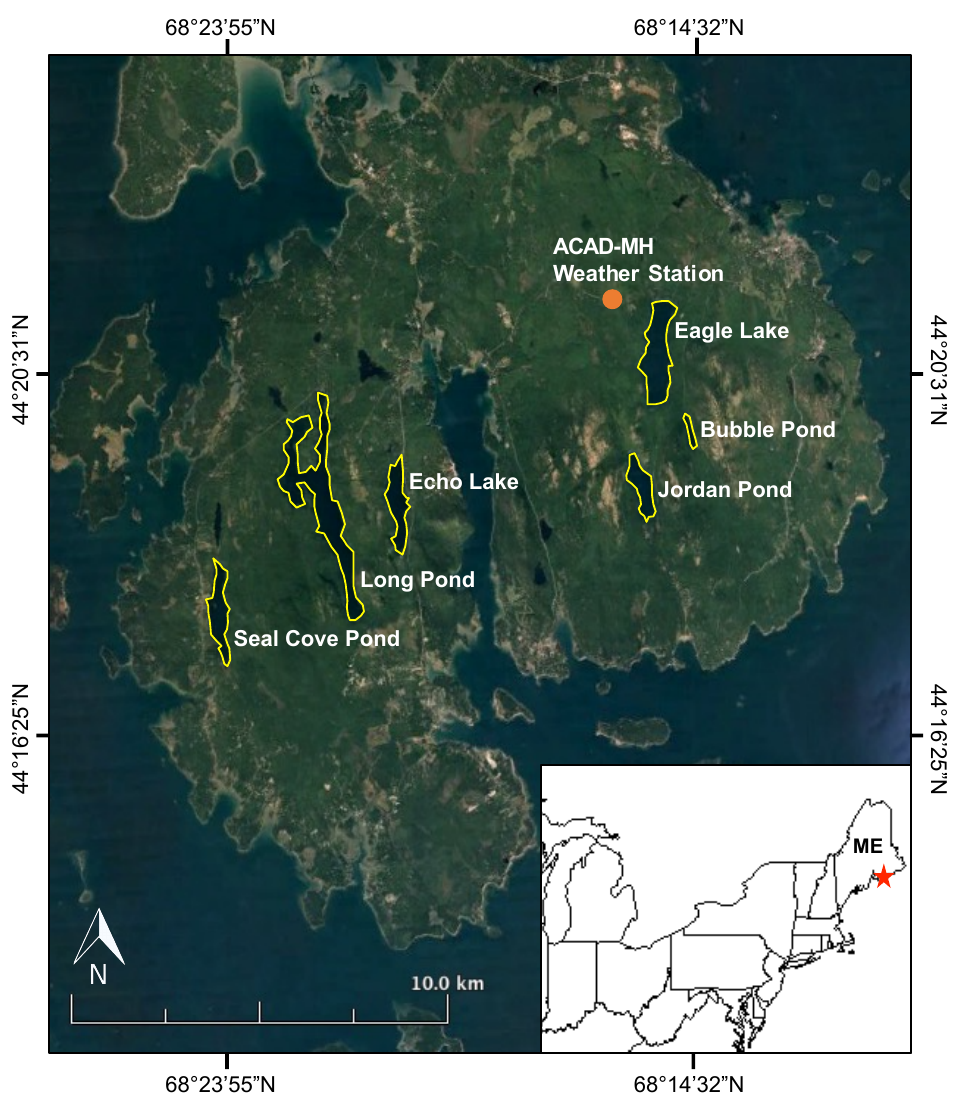
Figure 1. Map of the study area in Acadia National Park, Maine, USA with the six study lakes outlined in yellow and weather station designated by the orange